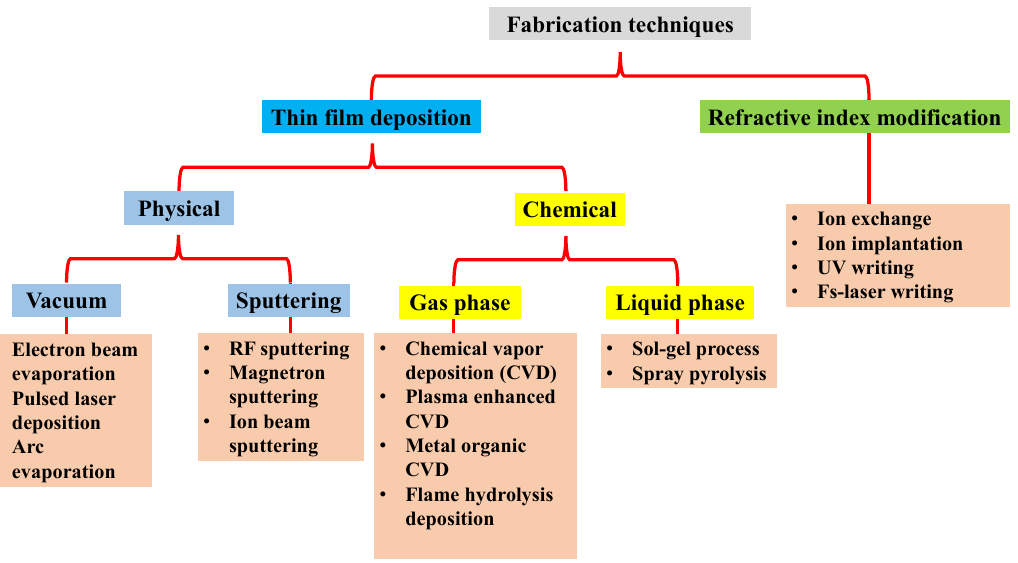
Figure 1. A layout of most widely used techniques to fabricate glass optical WGs. Inspired by [21].